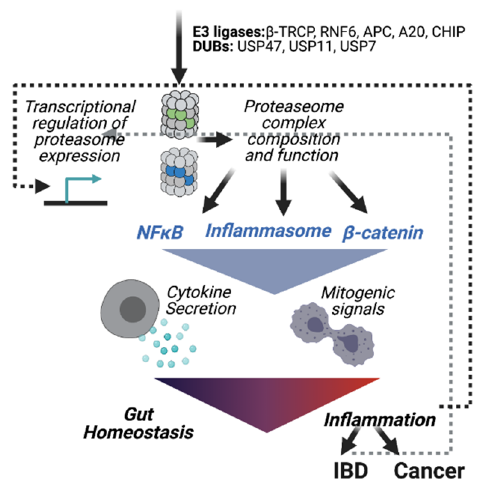
Figure 3. Snapshot of ubiquitin proteasome-dependent gastrointestinal inflammation and colorectal cancer. Gut homeostasis is regulated via the function of various ubiquitination enzymes (E3 ligases and DUBs) that regulate NFκB signaling, inflammasome activation, and β-catenin signaling. Altered expression or functions of ubiquitination enzymes, or proteasome subunits, is associated aberrant production of pro-inflammatory cytokines and immune cell differentiation, which disrupts homeostasis and promotes gut inflammation, potentially inducing chronic inflammatory bowel disease or colorectal cancer.